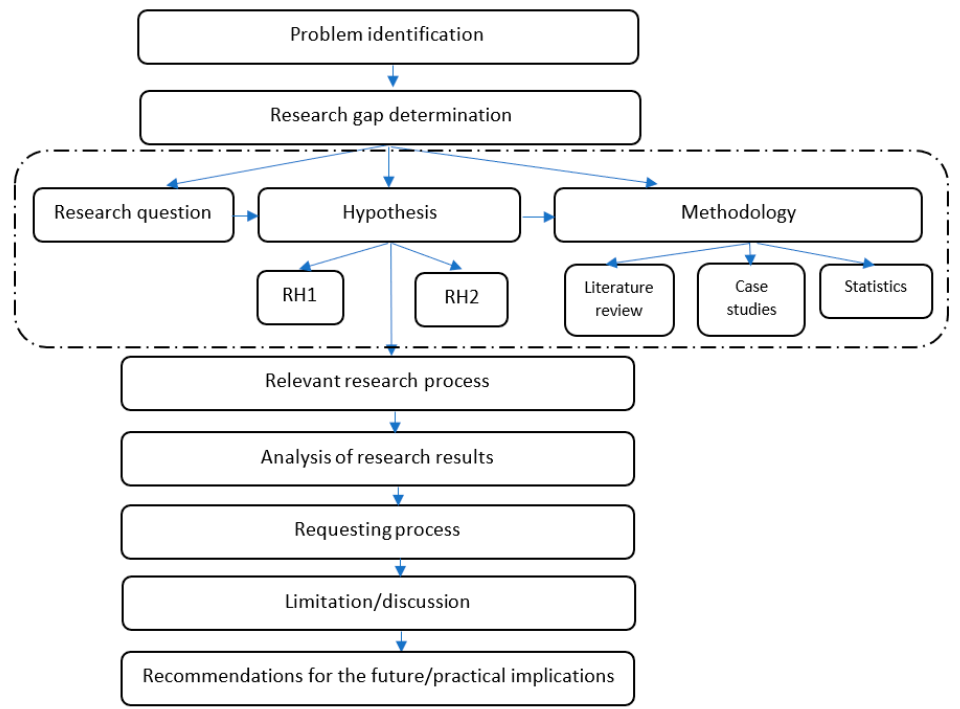
Figure 1. Research process framework.